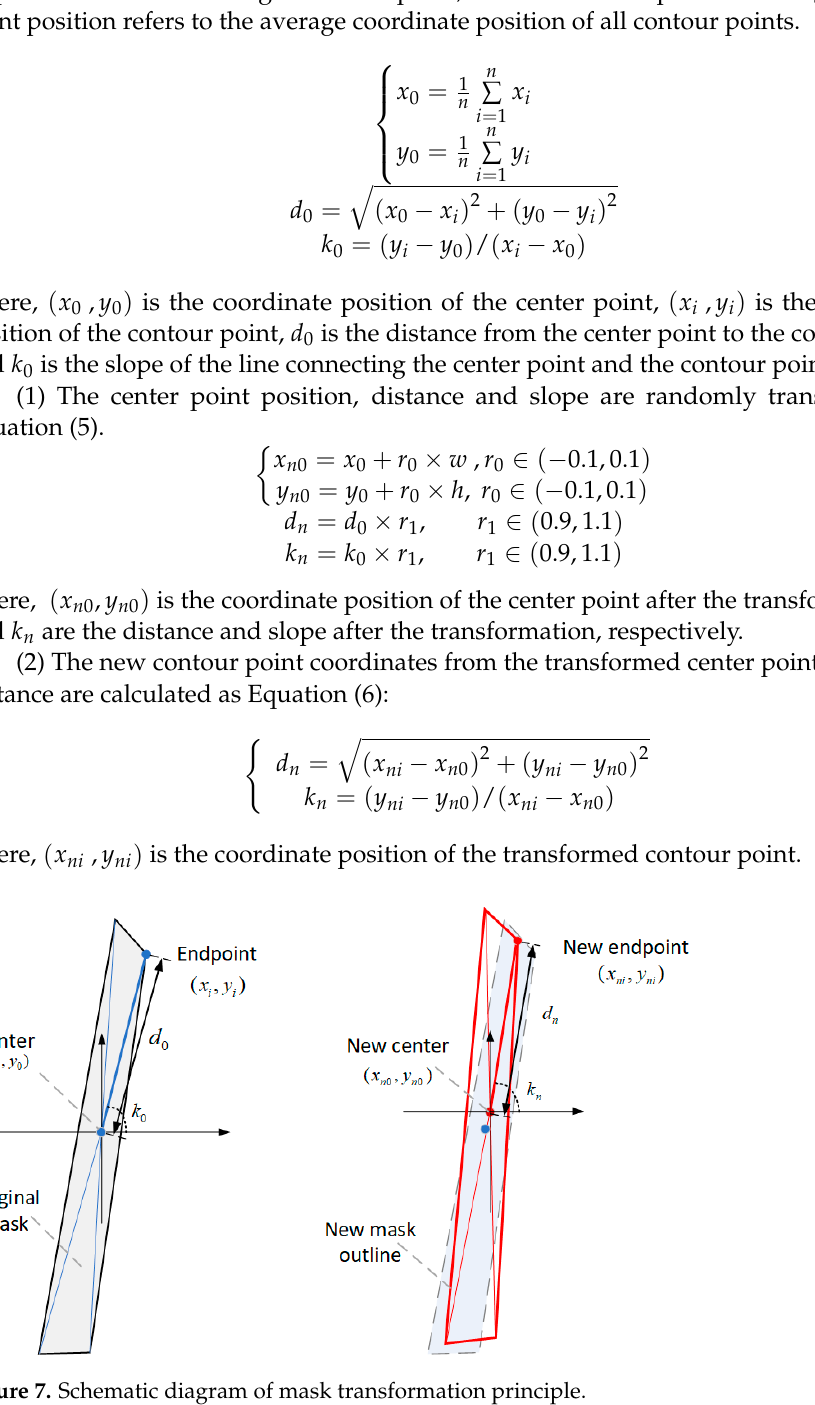
Figure 8. Mask random transformation results. 2.3.2. 3D Reconstruction of Utility Poles The transformation of the world coordinate system, camera coordinate system, im- age coordinate system, and pixel coordinate system will be involved in the generation of the pole. In Figure 9, 𝑃 (cid:3050) is a point in space, which is represented by ( 𝑋 (cid:3017)(cid:3050) , 𝑌 (cid:3017)(cid:3050) , 𝑍 (cid:3017)(cid:3050) ) in the world coordinate system and ( 𝑋 (cid:3017)(cid:3004) , 𝑌 (cid:3017)(cid:3004) , 𝑍 (cid:3017)(cid:3004) ) in the camera coordinate system. The point 𝑃 (cid:3050) on the imaging plane is denoted by p , which is represented as (𝑥, 𝑦) in the im- age coordinate system and ( u, v ) in the pixel coordinate system.